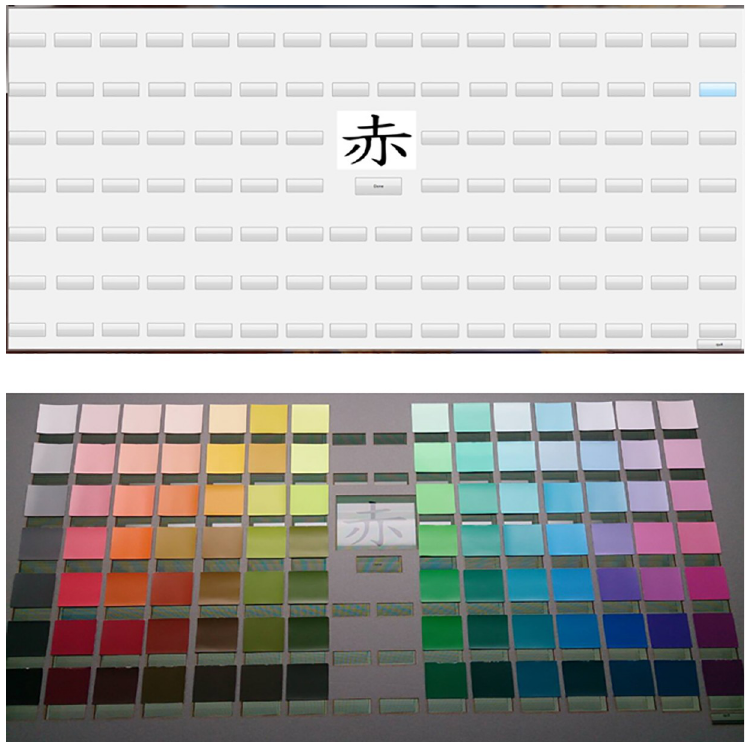
Fig 3. Screen shot of the touch screen monitor. Cards on which color chips had been mounted were attached to it for the survey, as shown.